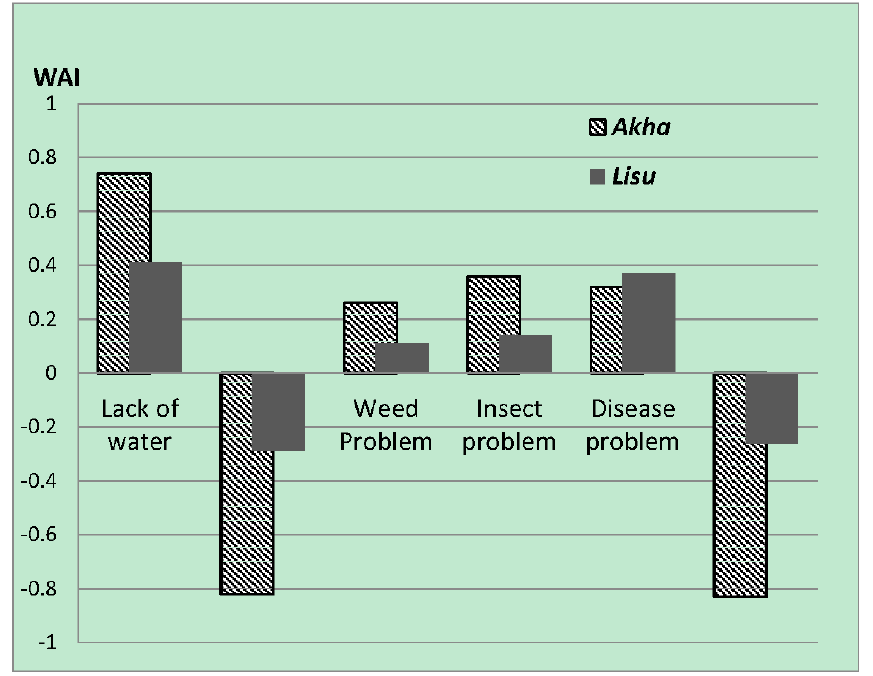
Figure 7. Perceived impacts of climate change.